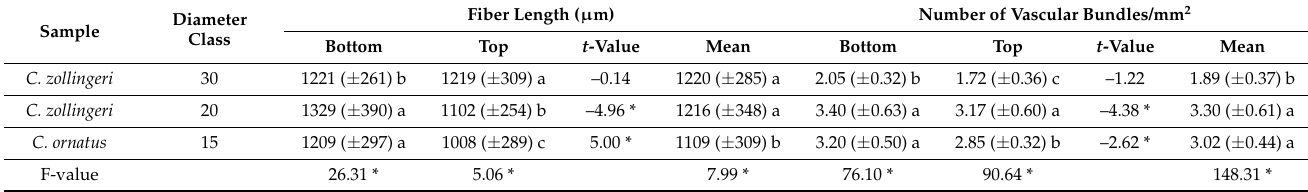
Table 2. Mean values of fiber length and number of vascular bundles of different fully polished rattan samples. Mean values ( ± standard deviations) of n = 100 per sample type for fiber